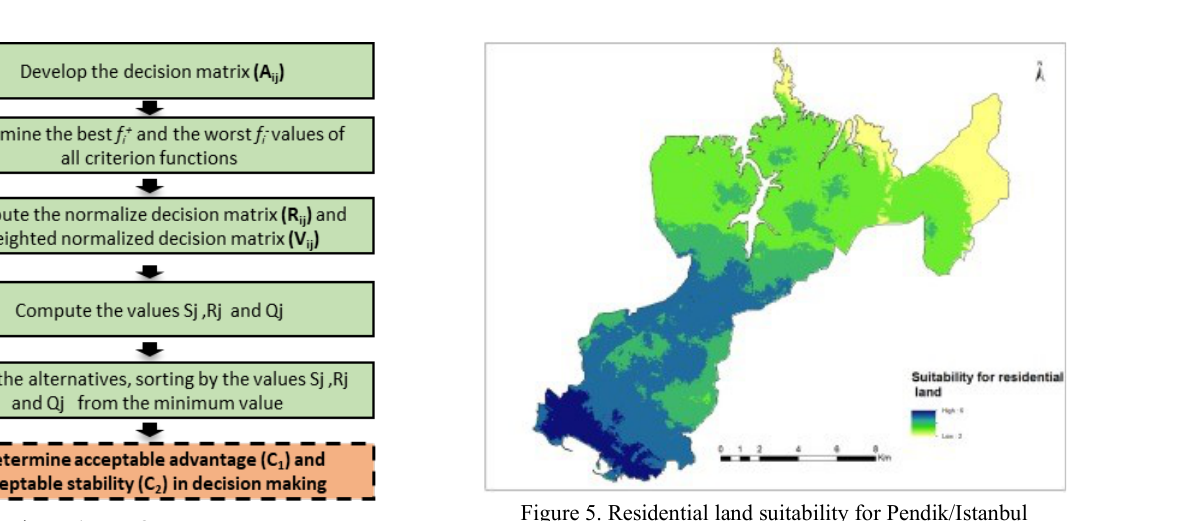
Figure 4. VIKOR process steps